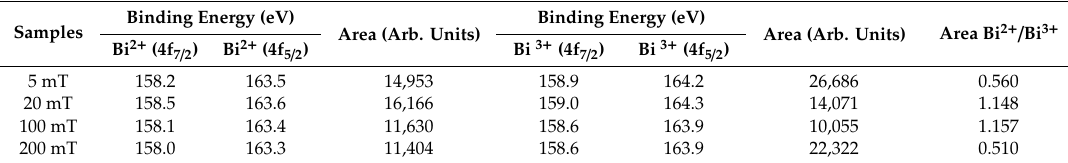
Figure 16. High ‐ resolution XPS spectra of ( a ) Bi 4f and ( b ) O 1s for Bi 2 O 3 :Ho 3+ thin films deposited at different O 2 partial pressures with constant substrate temperature (400 °C). Table 6. Bi 4f peak positions and peak areas of the Bi 2 O 3 :Ho 3+ thin films deposited at different O 2 partial pressures (T S = 400 °C).